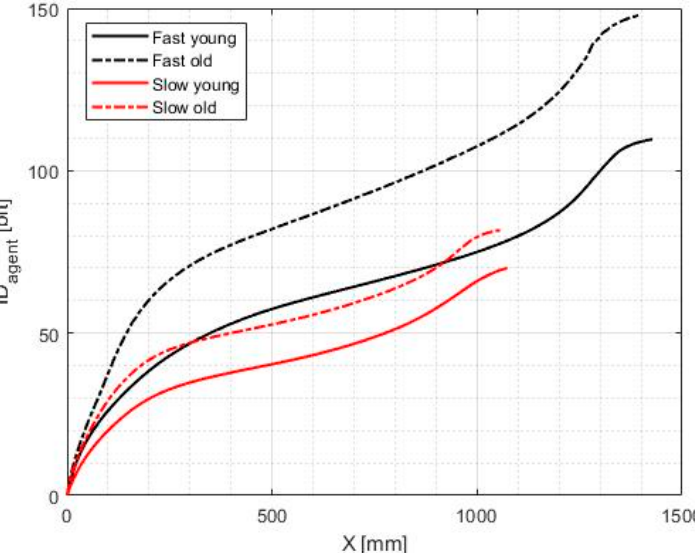
Figure 7. Average (cid:1835)(cid:1830) (cid:3028)(cid:3034)(cid:3032)(cid:3041)(cid:3047) ((cid:1876), (cid:2030) = 0.96) observed for “Young” (continuous lines) and “Old” (dot- ted lines) at “Slow” (red lines) and “Fast” (black lines) speed